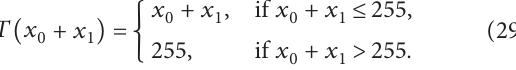
(Figure 15) to test the robustness of algorithms. The image in noise is denoted as 􏽥 x where